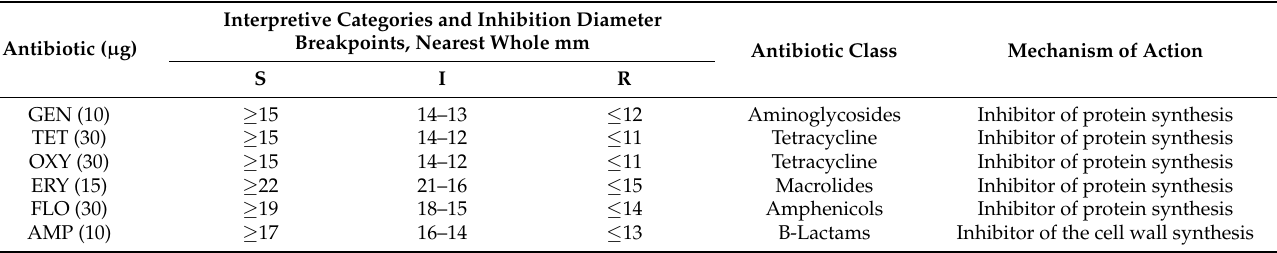
Table 1. Antibacterial susceptibility standards for testing, by the disc diffusion antibiotic method [59] and, classification of antibiotics [60] used in this